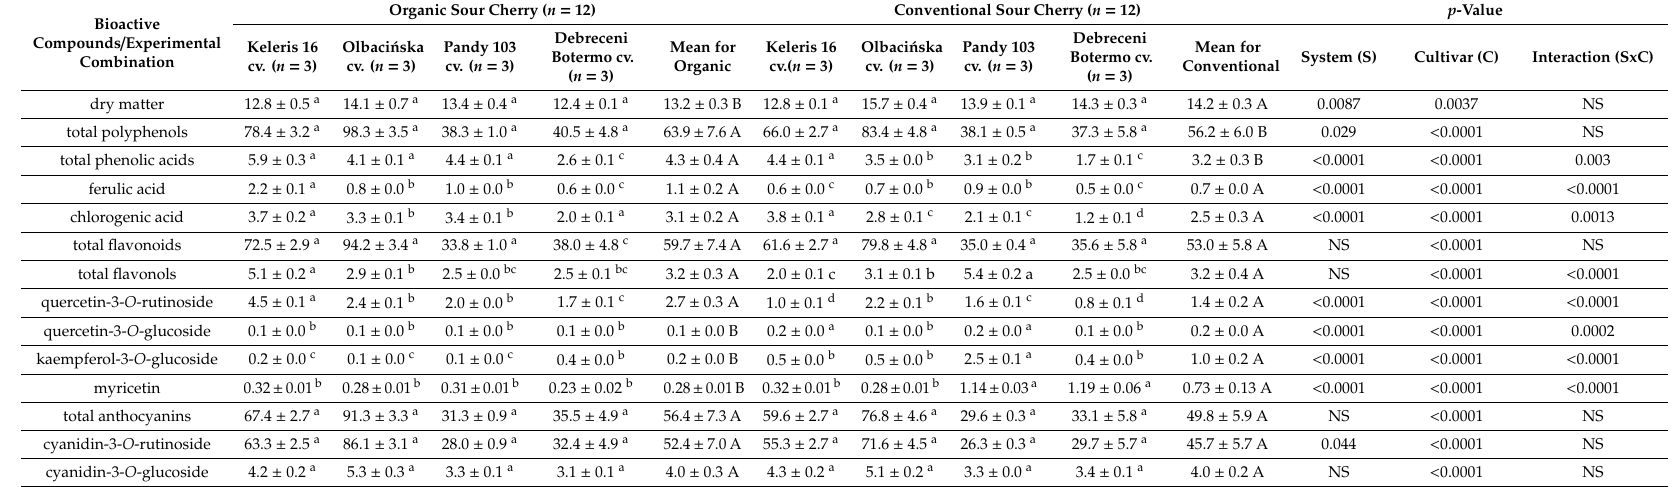
Table 3. The content of dry matter (in g / 100 g FW) and polyphenols (in mg / 100 g FW) in examined sour cherry cultivars in